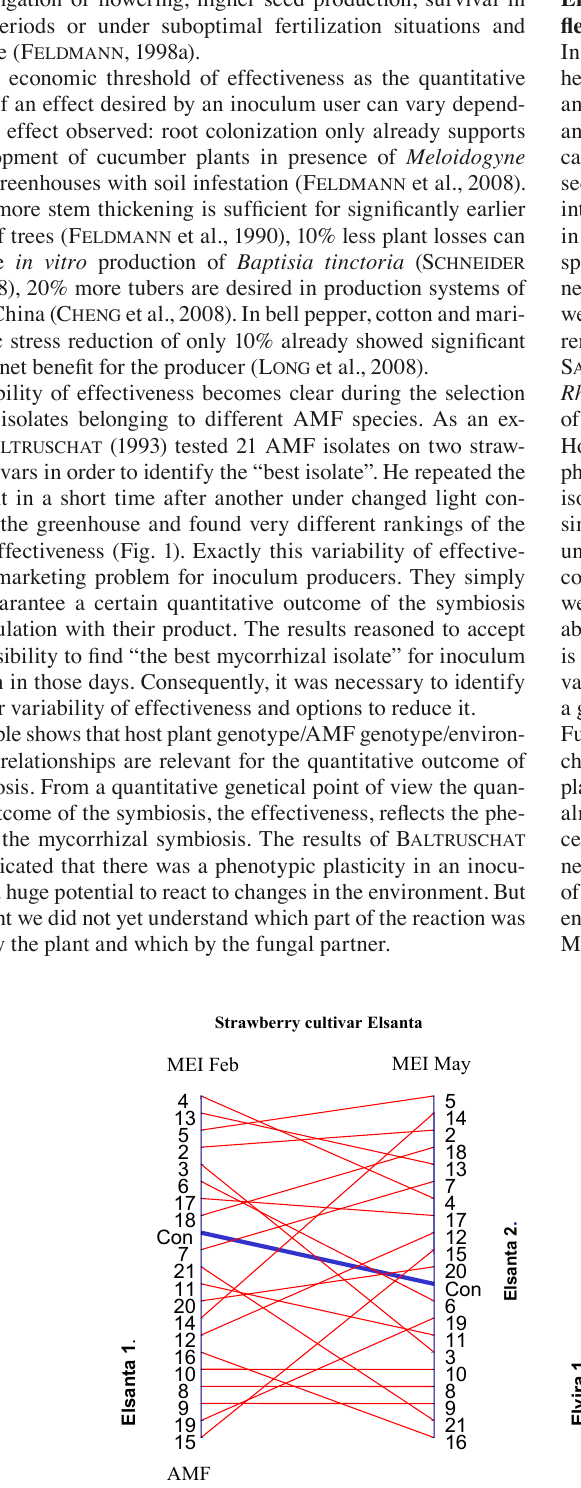
Fig. 1: Variability of mycorrhizal effectiveness on fresh weight after inoculation of two strawberry cultivars in two subsequent repetitions (ranked from „best“ isolate (top) to „worst“). The mycorrhizal effectiveness index (MEI) is the percentage difference between mycorrhiza inoculated and not inocu- lated plants (Con). Numbers are the isolate numbers used for inoculation. Ranking below Con means fresh weight reduction, above Con fresh weight increase of mycorrhiza inoculated plants. The figure was drawn based on data derived from b aLtruschat